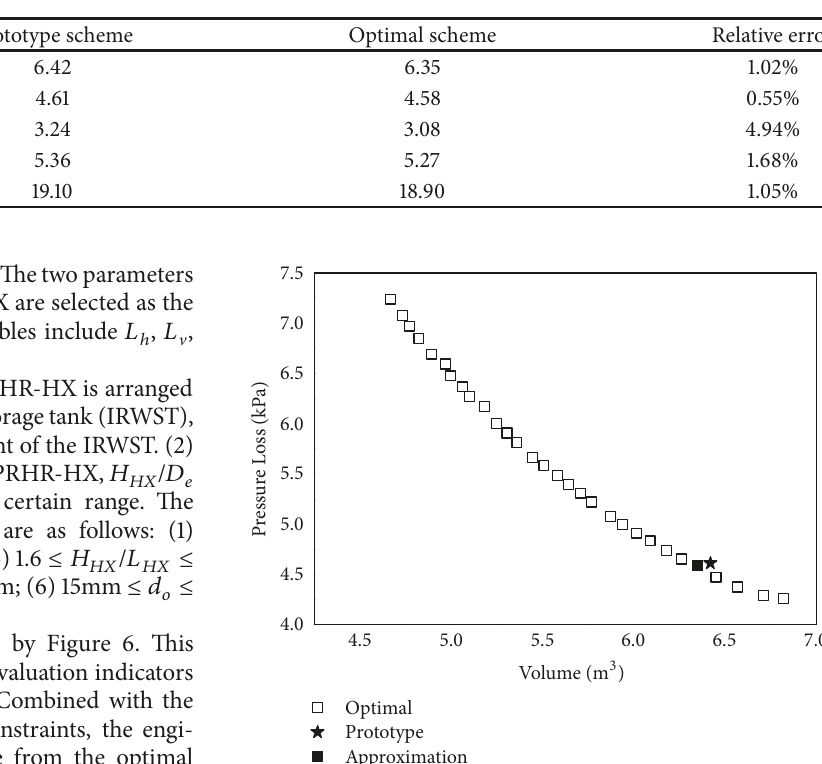
Table 4: The parameters of optimal designs.